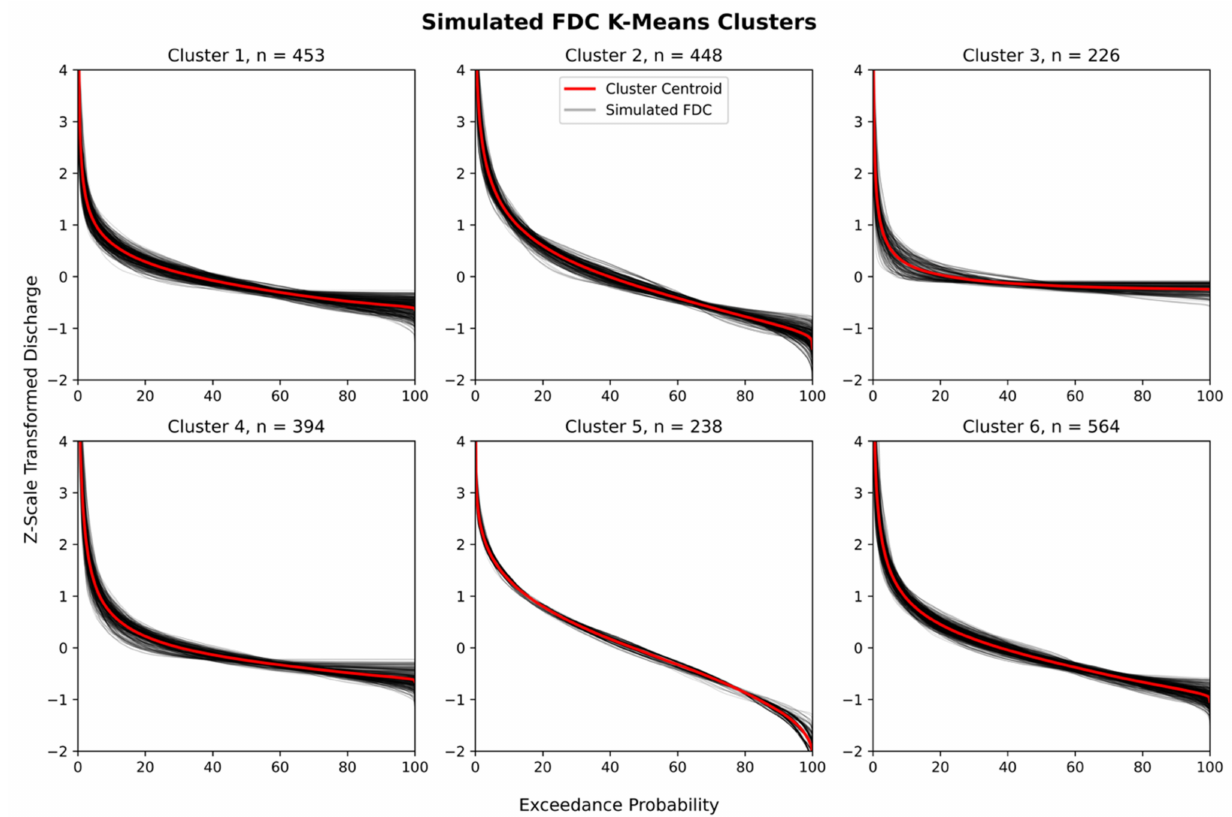
Figure 3. Simulated flow duration curves clustered in six groups using k-means and dynamic time warping measures. Cluster centroids are shown in red, and individual flow duration curves are shown in